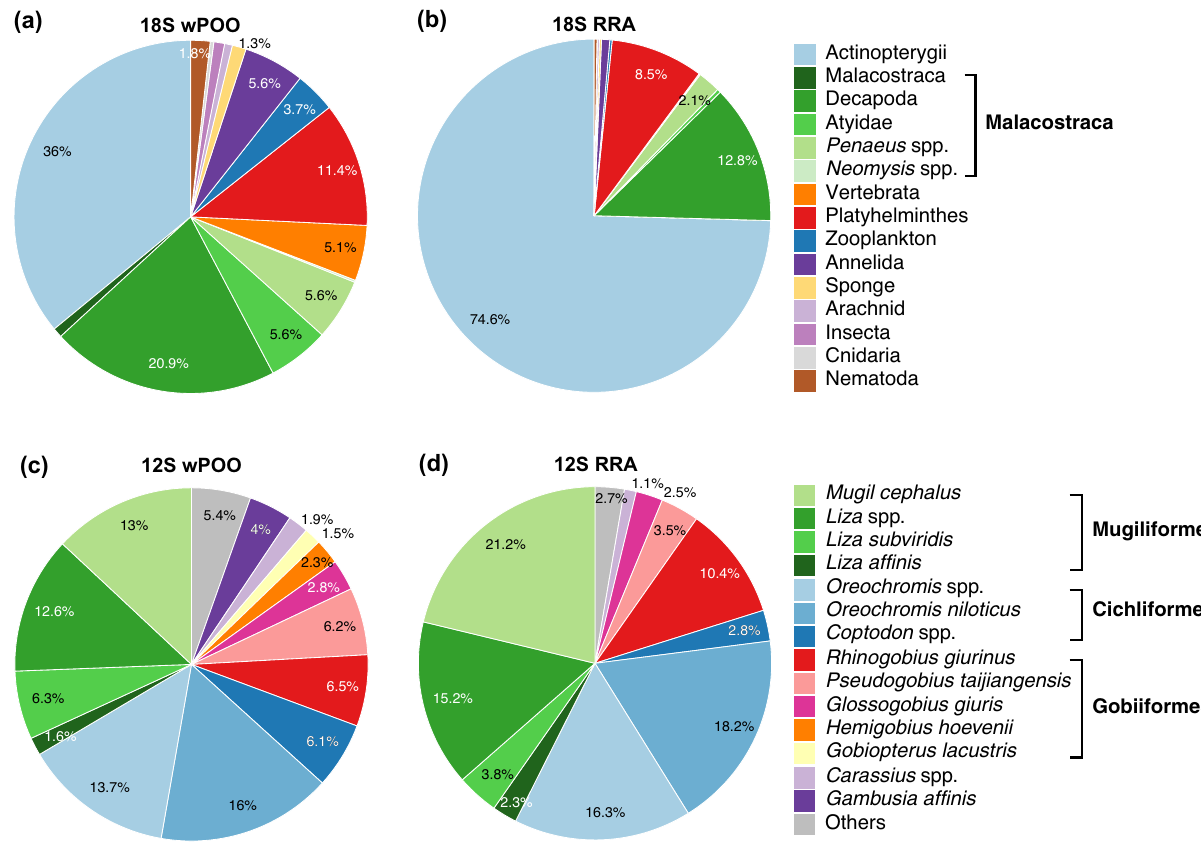
Figure 2. Taxa compositions identified in the fecal samples of Platalea minor . Weighted percentage of occurrence (wPOO) and relative read abundance (RRA) of all detected taxa were analyzed using (a,b) 18S (n = 110) and (c,d) 12S (n = 96) metabarcoding data. Color blocks represent 15 metazoan taxa of 18S rDNA (at or above genus level) summarized from 40 taxonomic groups and 14 major fish taxa (at or above species level). The remaining 15 minor fish taxa (RRA or POO < 1%) were grouped into